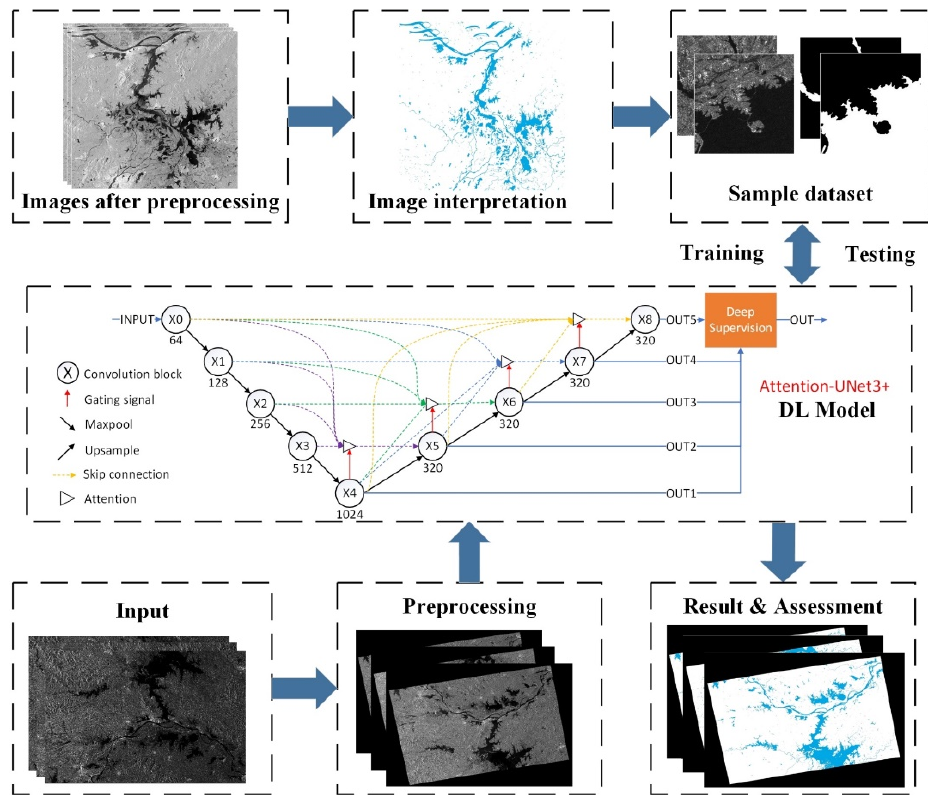
Figure 1. Methodological framework of the overall methods used in this